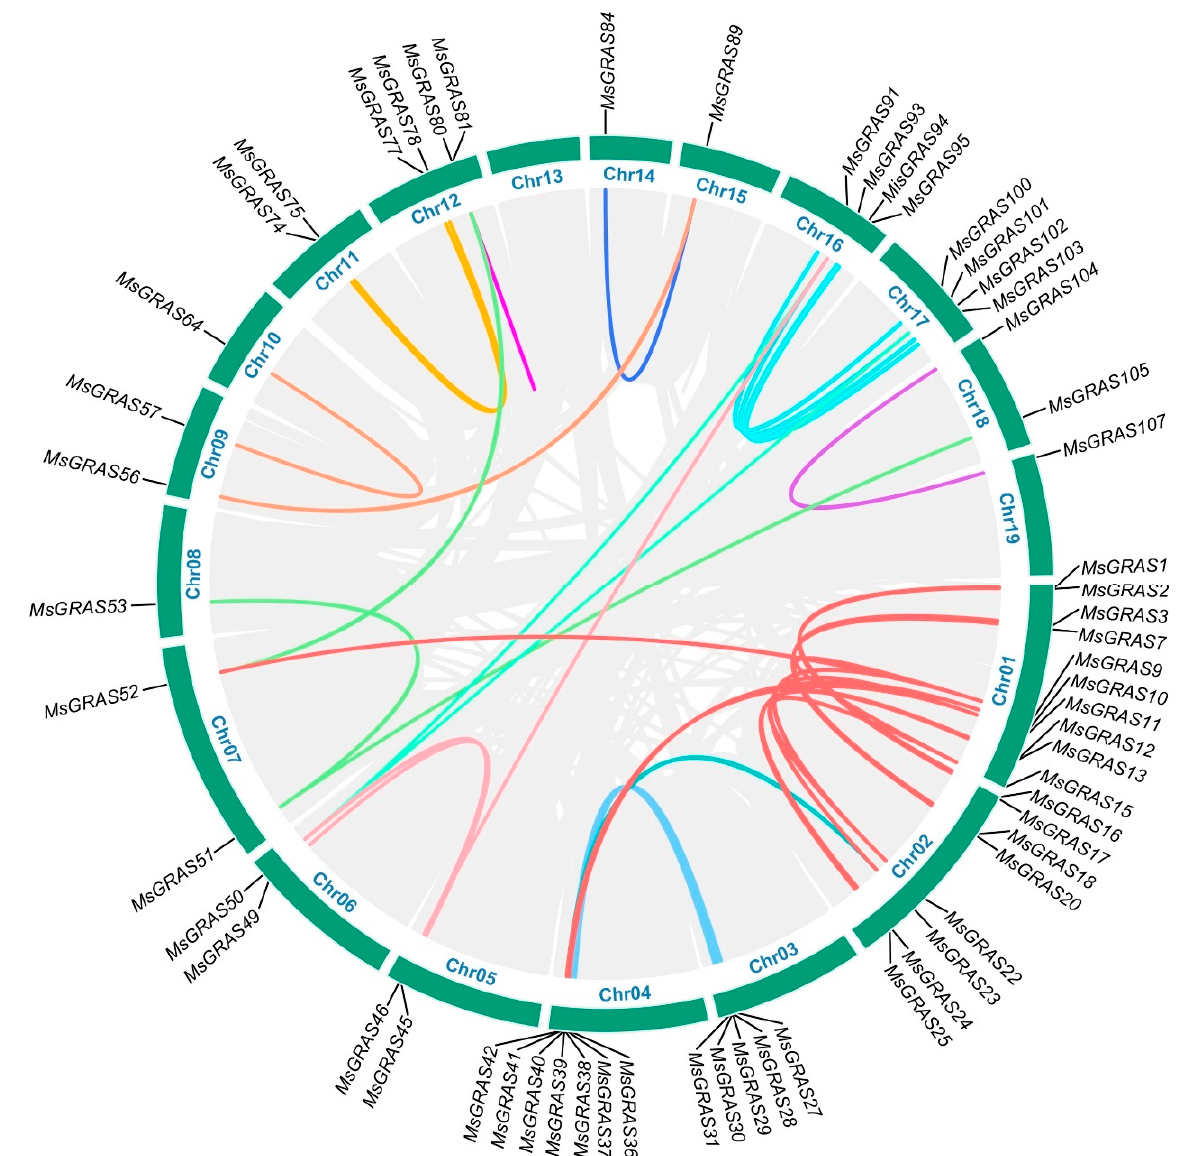
Figure 1. Segmental duplication relationships of MsGRAS genes. Grey lines indicate all synteny blocks in the M.sinensis genome. Lines in the same colors indicate duplicated GRAS gene pairs. The chromosomes are marked with Chr01 to Chr19 in blue for each chromosome.